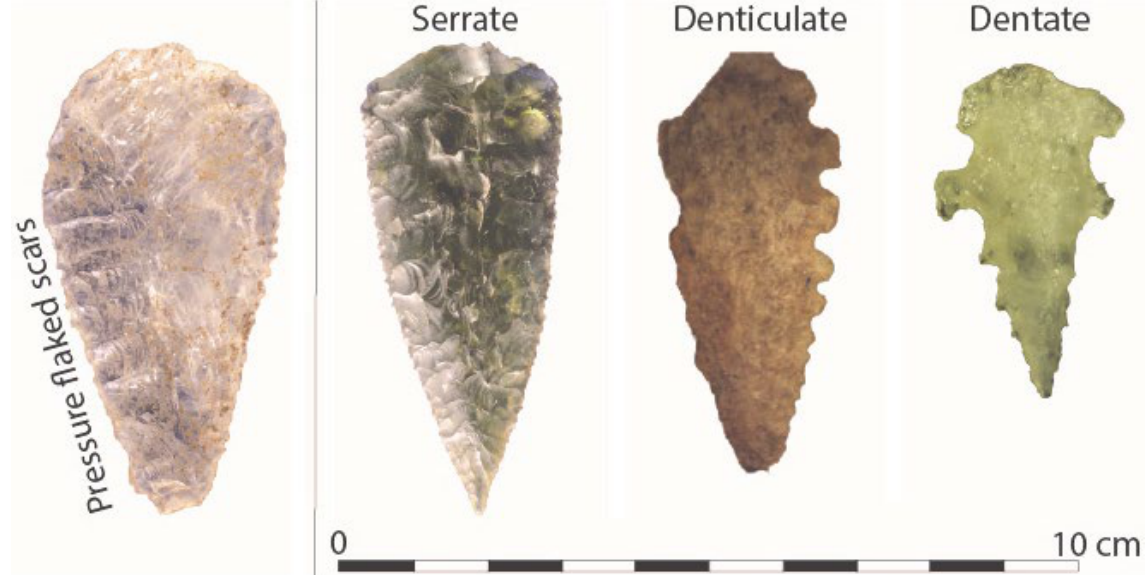
Figure 4. Examples of pressure flaked bifaces (a.k.a. Kimberley Points) from the study area conveying: A) Collateral pressure flaked scars - Mt Behn, B) Kimberley Point (serrate) - McSherry’s Gap, C) Kimberley Point (denticulate) - LR9 and D) Kimberley dentate Point - LR12.